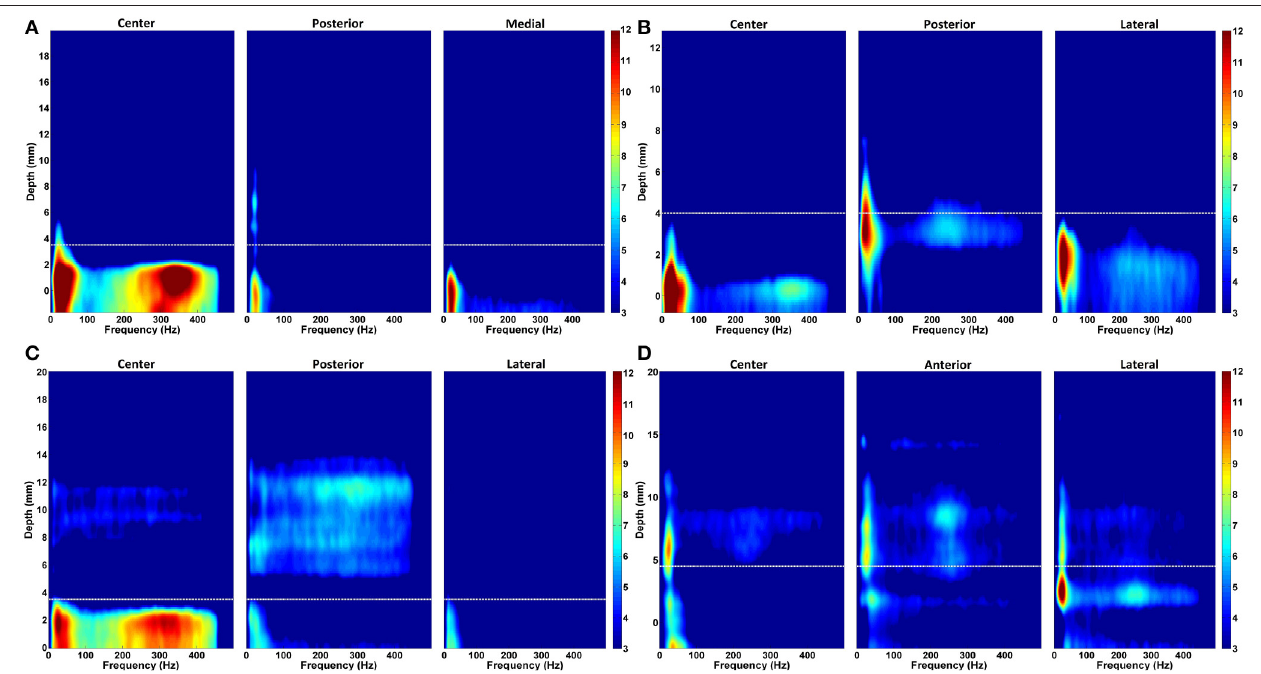
FIGURE 7 | Normalized depth-frequency maps. Representative normalized DFMs of de-correlated LFP data of all three tracks from four representative patients are shown. (A) The excessive beta oscillations can be clearly seen in the first subject dominantly in the center track and localized to certain depths. There is a strong and track-specific HFO around 350Hz which is well aligned with the low band activity. In this subject, selected track by neurosurgeon for the DBS electrode implantation is center track. (B) Beta oscillations are observed in all tracks along with HFOs. The HFO in the center track sits at 350Hz while it is located at 250Hz in the posterior track. The lateral track shows wider but weaker oscillations. The selected track by neurosurgeon is lateral. (C) A similar LFP characteristics to the first subject (shown in A ) with dominant beta oscillations and HFOs in the center track can be seen. Similarly, these oscillations are well aligned below the border and highly stronger than the beta oscillations in the other two tracks. Center track is selected for DBS electrode implantation. (D) These DFMs show different LFP characteristic compared to others. None of the tracks shows strong, long span beta oscillations. Specified border is not aligned with beta oscillations. All three tracks demonstrate spatially different weak-to-minor HFOs. The white dashed line indicates the dorsal STN border. In this subject, the selected track is